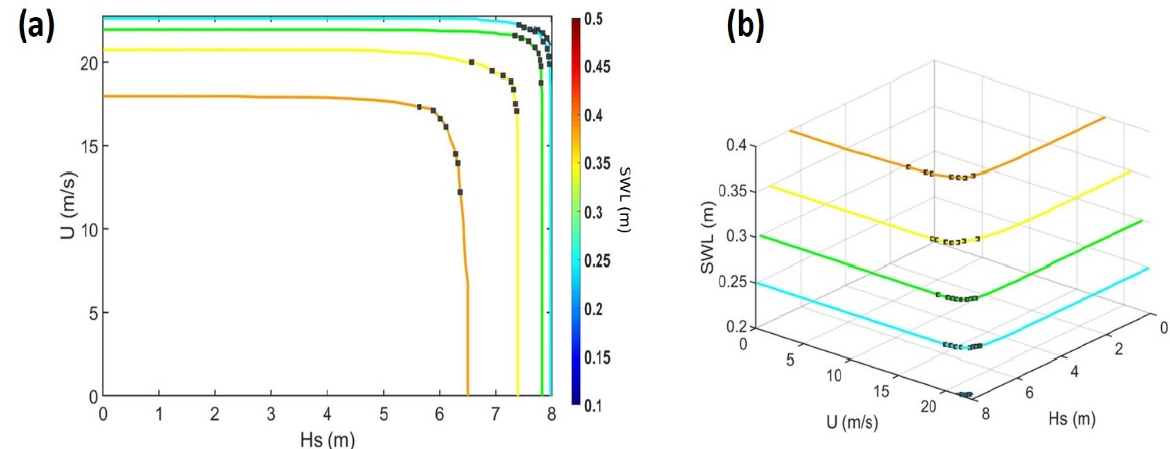
Figure 5. ( a ) Representation of the 100-year joint exceedance isocontours for the dataset NWW3 560/MARS 8. The color of the isocontours represent the SWL values from 0.2 to 0.4 m. ( b ) Simplified 3D representation of the 100-year joint exceedance isocontours for the dataset NWW3 560/MARS 8. The black dots represent the selected combinations given as input of the hydrodynamic